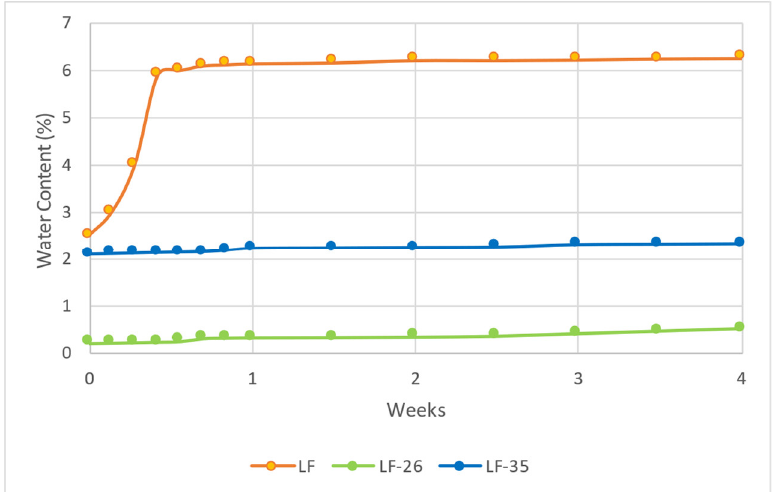
Figure 10. Hydrate transformation profile of LF (levofloxacin), LF-26 (levofloxacin-2,6 dihydroxybenzoate), and LF-35 (levofloxacin-3,5 dihydroxybenzoate) for four weeks in condition 75 ± 1.0% RH/25 ± 0.5 °C.